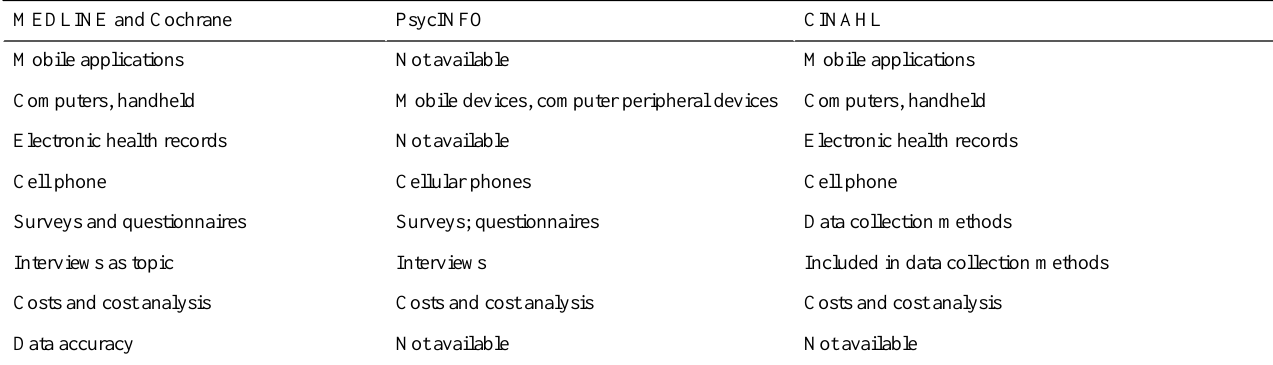
Table 1. Subject term translations for individual databases CINAHLPsycINFOMEDLINE and